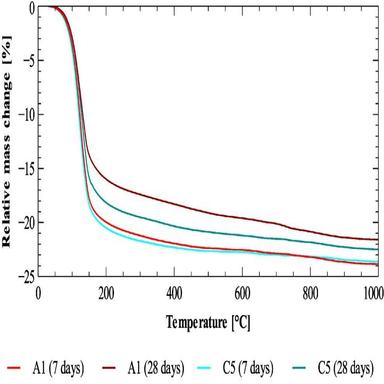
Thermogravimetry of A1 and C5 mixtures after 7 and 28 days.